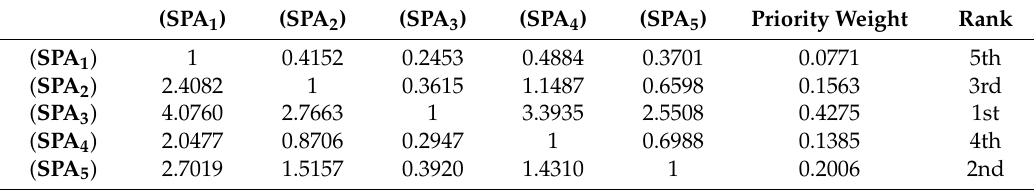
Table A7. Pair-wise comparison matrix of socio-political